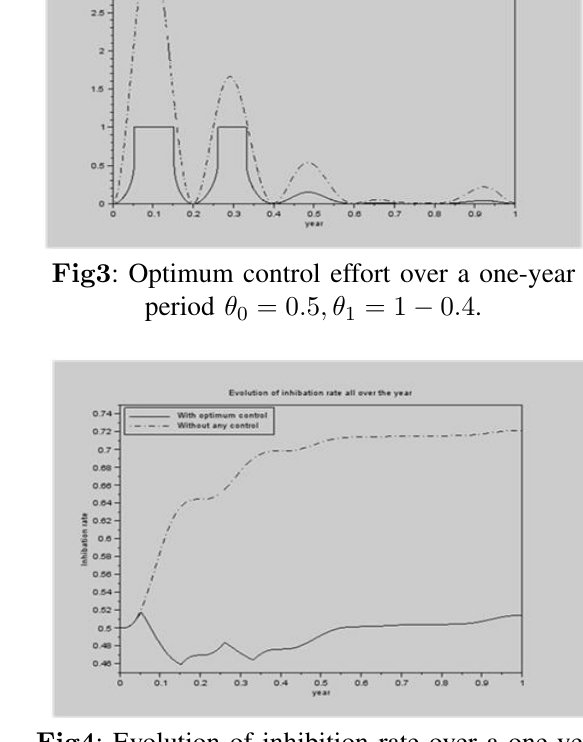
Fig4 : Evolution of inhibition rate over a one-year period θ 0 = 0 . 5 , θ 1 = 1 − 0 . 4